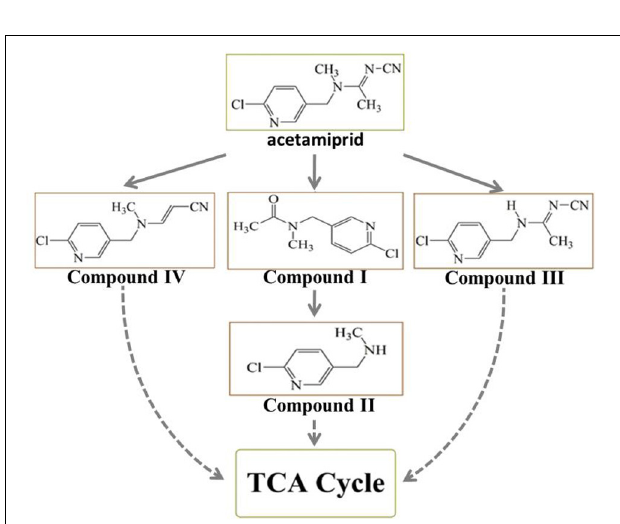
FIGURE 4 | The proposed metabolic pathway of acetamiprid degradation by consortium ACE-3. The dotted line indicates a putative metabolic pathway.